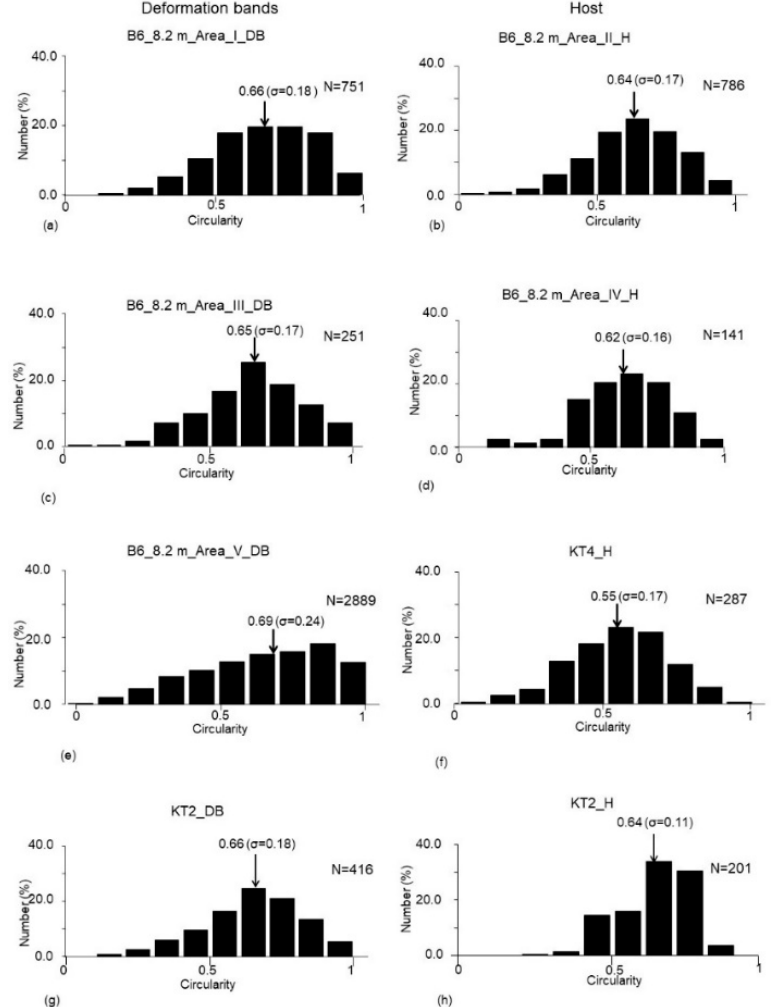
Figure 14. The histogram of circularity for the ( a , c , e , g ) four deformation bands and ( b , d , f , h ) four host areas in the core and outcrop samples. Sample name is shown at the top of each diagram. The average value and one standard deviation ( σ ) are also shown.